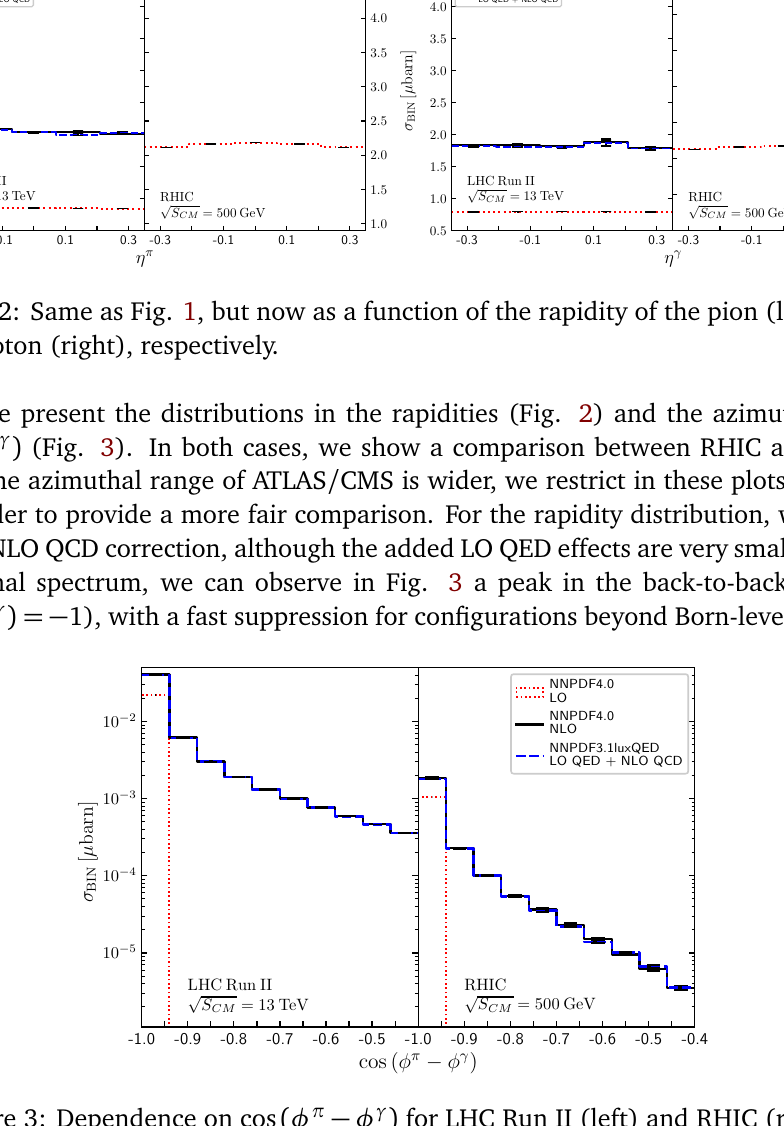
Figure 3: Dependence on cos ( φ π − φ γ ) for LHC Run II (left) and RHIC